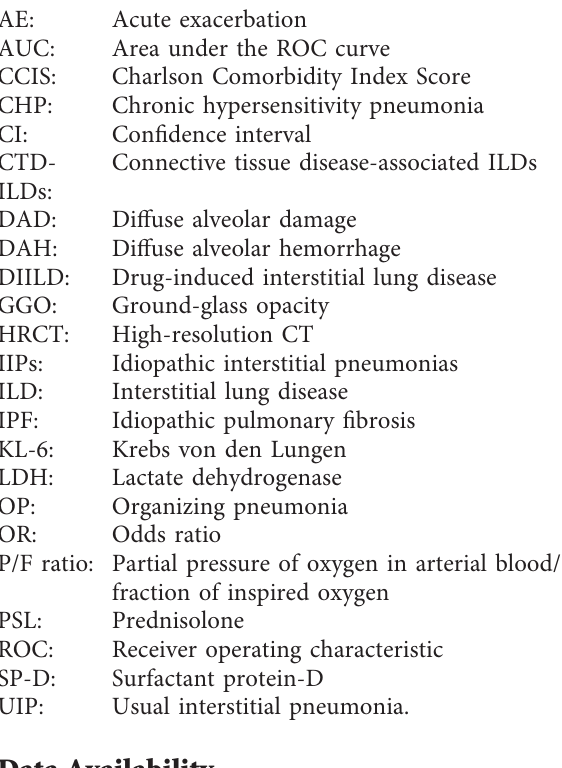
Figure S1. Comparison between patients with high honey- comb and reticular fibrosis score and low. Similar with the honeycomb score, there was no significant difference in 3- month mortality among the groups with low and high fi- brosis score including reticular fibrosis and honeycomb score. Figure S2. Comparison of patients with and without honeycombing 6 months after AE. There is no significant difference in 6-month mortality between those with and without honeycombing in patients with AEs of idiopathic ILDs, AEs of secondary ILDs, and overall patients. AE, acute exacerbation; ILD, interstitial lung disease. . ( Supplementary Materials